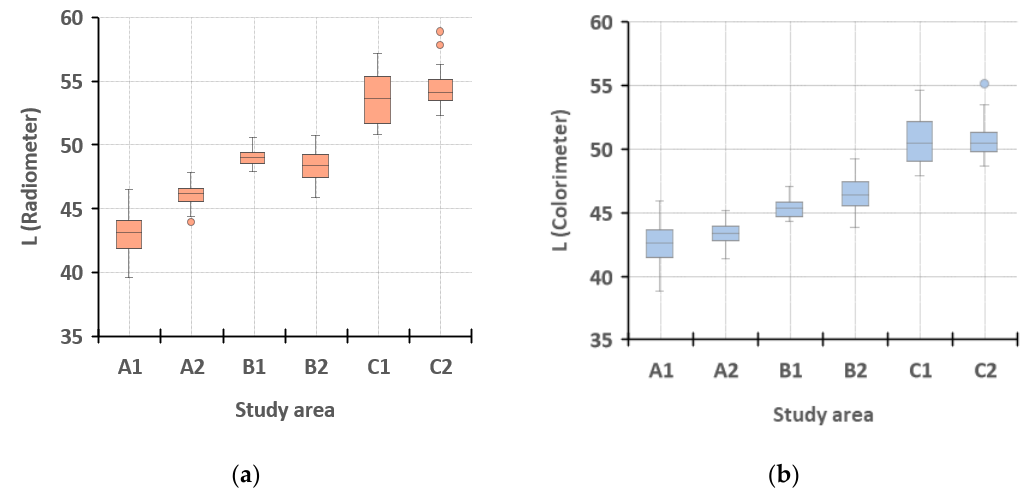
Figure 5. L* values after spectroradiometer ( a ) and colorimeter ( b ) measurements over the study area.